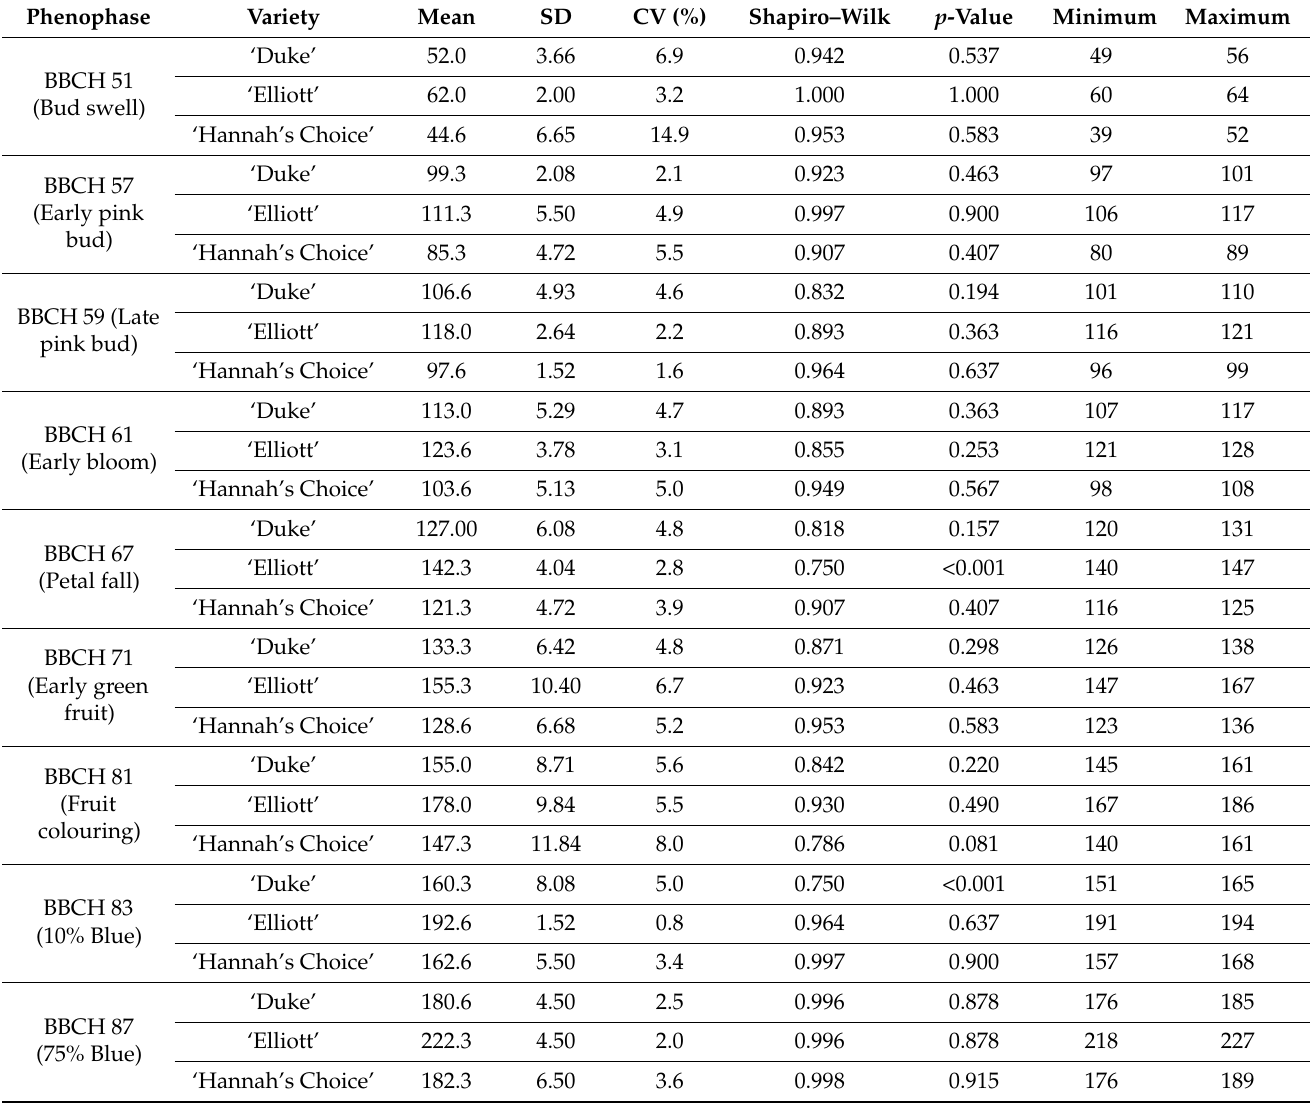
Table 1. Descriptive statistics regarding the influence of variety on generative phenophases of blueberries grown in the low hilly area of Banat